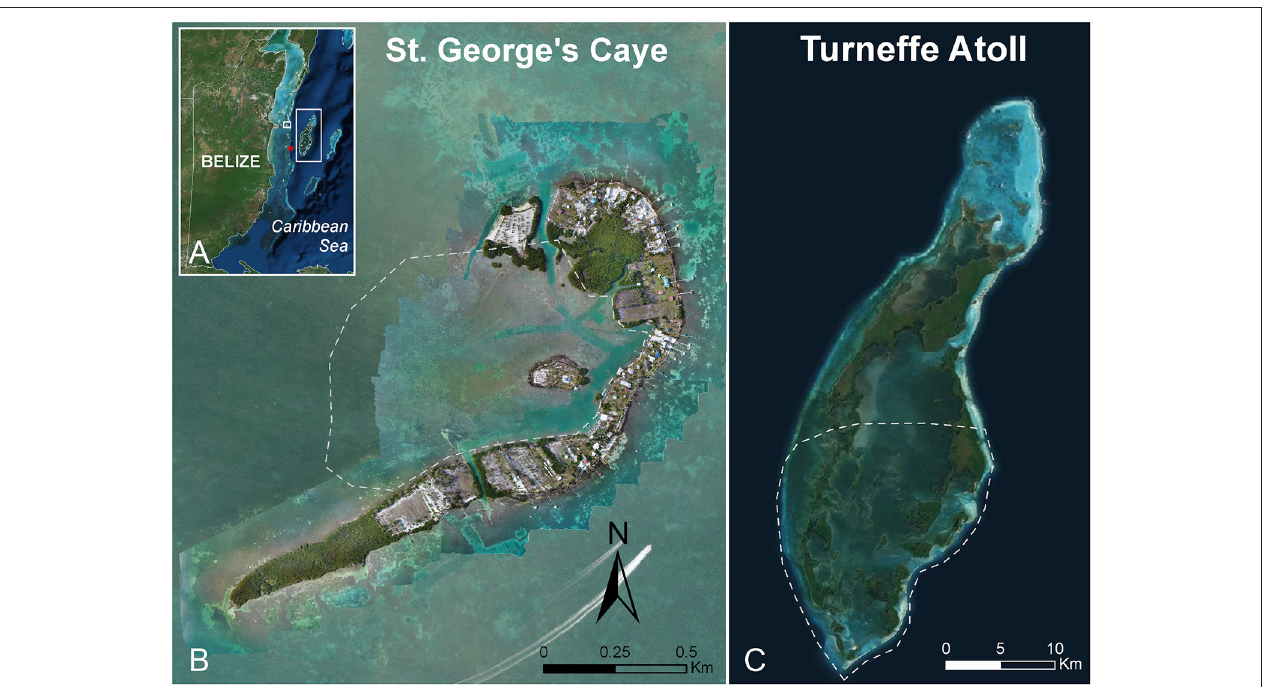
FIGURE 1 | (A) Map of Belize. (B) St. George’s Caye, located east of mainland Belize near the Belize Barrier Reef, with overlaid orthomosaic maps. (C) Turneffe Atoll Marine Reserve is located in the offshore waters of Belize. Gray dashed lines outline study areas. The red star denotes flights conducted outside of the main study. Map Source: Esri, DigitalGlobe, GeoEye, Earthstar Geographics, CNES/Airbus DS, USDA, USGS, AeroGRID, IGN, and the GIS User